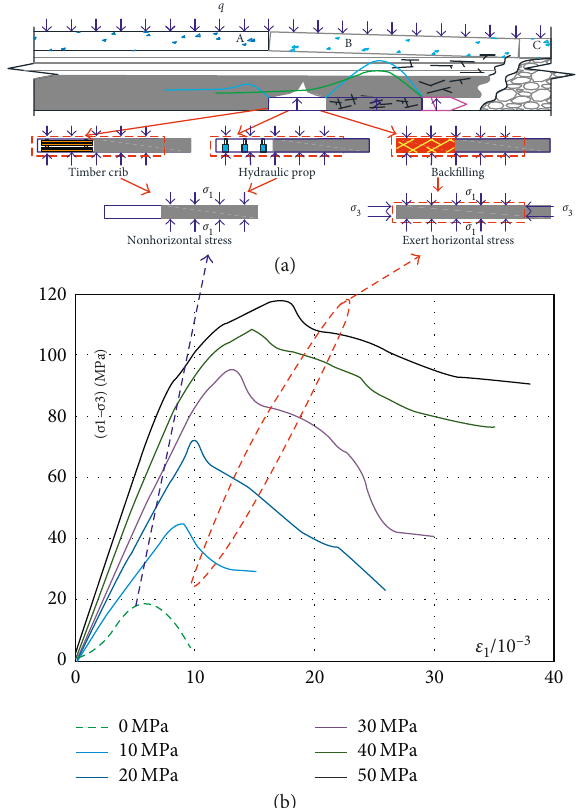
Figure 8: Schematic diagram for preventive